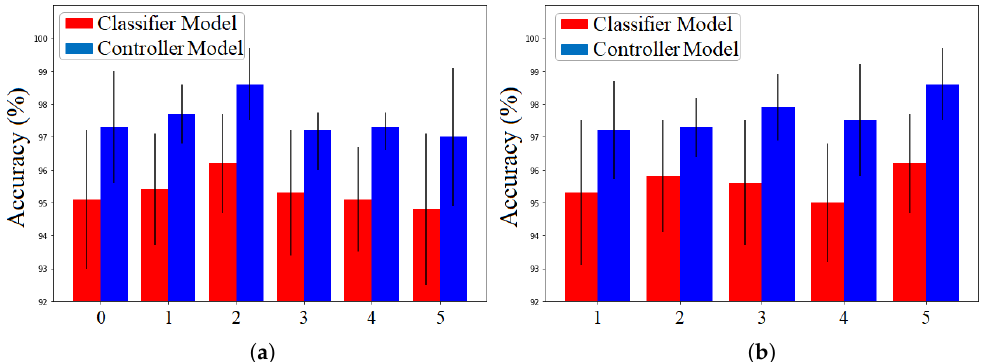
Figure 9. Performance of the proposed classifier and controller models with various values for α and β . Error bars illustrate ±1 standard deviation. ( a ) the effect of different values of α ; ( b ) the effect of different values of β